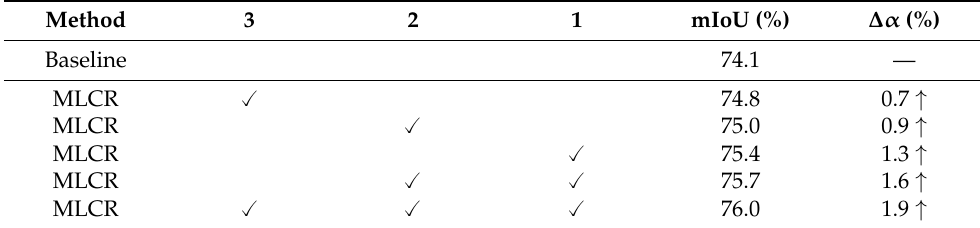
Table 1. Ablation results for MLCR module to different insert positions on Potsdam test